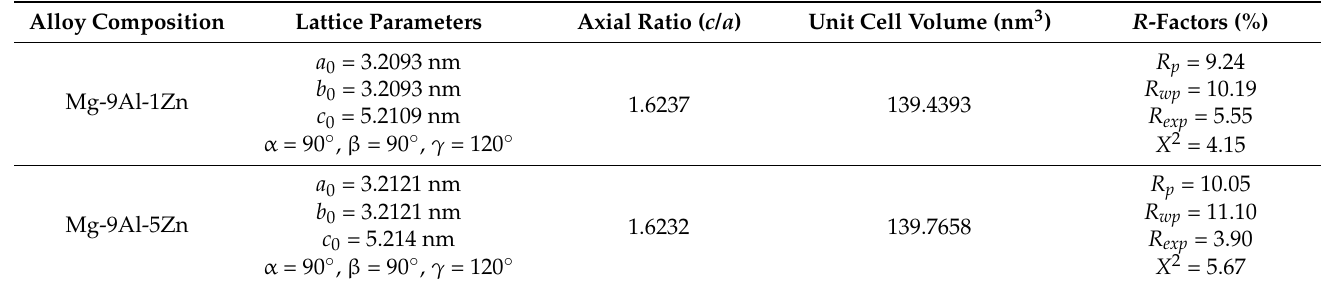
Table 1. Rietveld refined structural parameters for Mg-Al-Zn alloy foams: a dependency on the α -Mg phase.